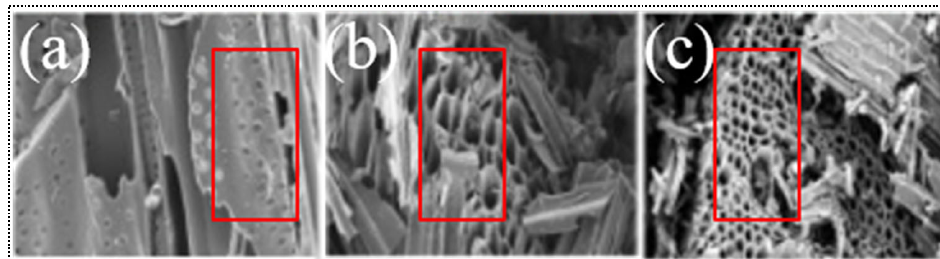
Figure 6. FESEM images: ( a ) HFPC-10, ( b ) HFPC-20, and ( c ) HFPC-30. Reprinted with the permission from Ref. [130]. Copyright © 2022 Elsevier B.V.